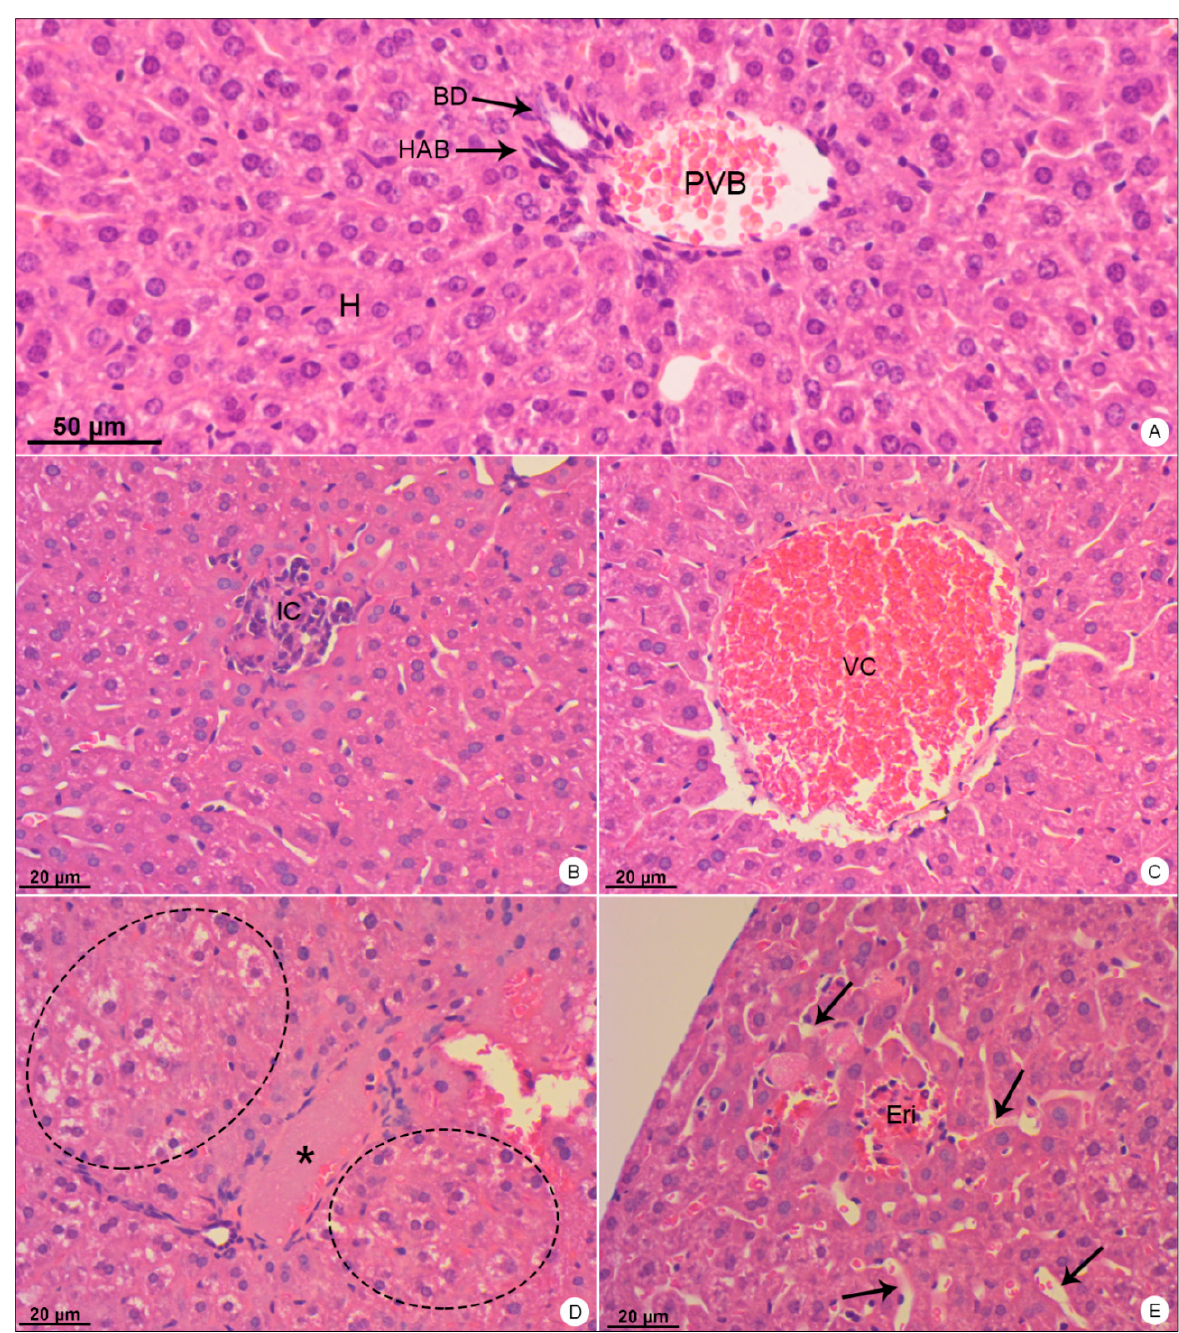
Figure 2. Liver samples of BALB/c mice stained with hematoxylin and eosin and observed in bright field microscope. ( A ) Negative control sample. Portal vein branch (PVB); hepatic artery branch (HAB); biliary duct (BD); hepatocytes (H). ( B – E ) DENV-4-infected samples. Inflammatory infiltrate (IC); vascular congestion (VC); edema (*); ballooning degeneration of hepatocytes (dashed outline); erythrocytes within the tissue (Eri); dilation of sinusoid capillaries (arrows). Magnification: ( A ) = 200×; ( B ) = 200×, ( C ) = 200×; ( D ) = 200×; ( E ) = 200×.